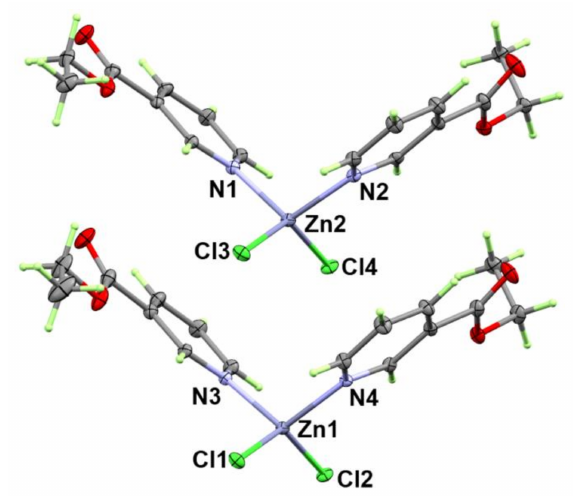
Figure 2. The asymmetric unit of the [Zn(EtNic) 2 Cl 2 ]